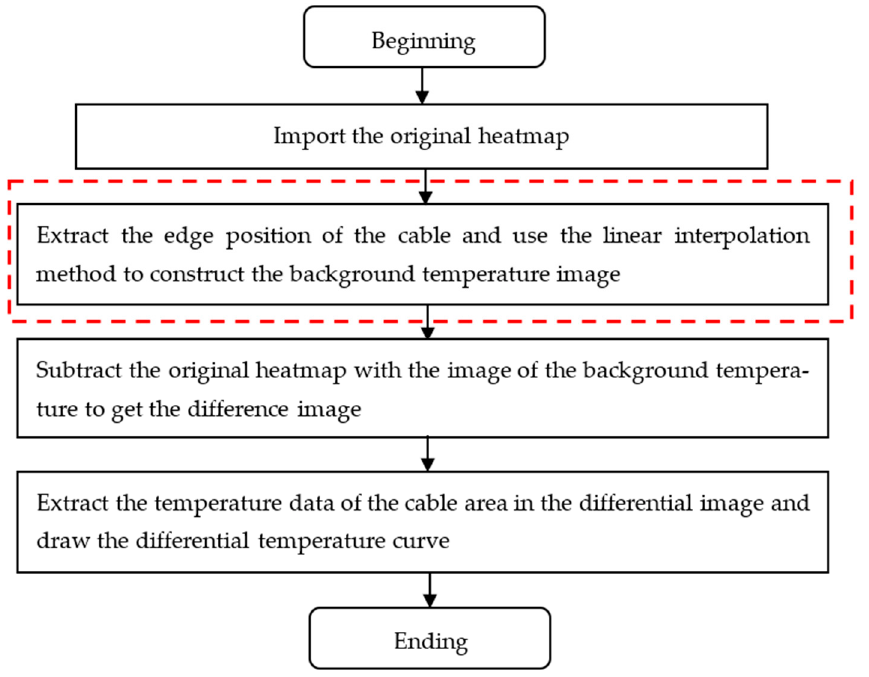
Figure 8. Flowchart of the infrared image processing for cable detection.